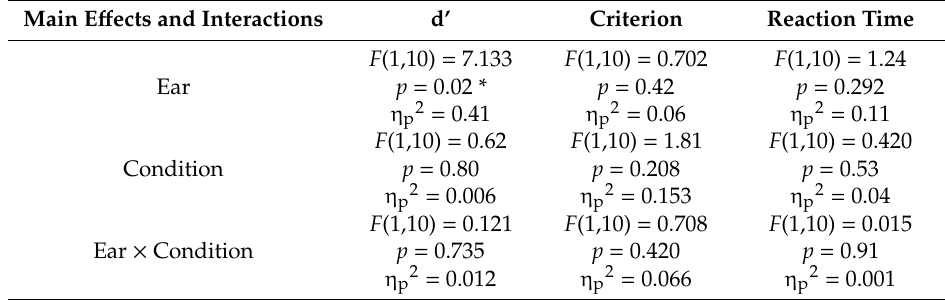
Table 8. Results of repeated-measures ANOVA for d’ (sensitivity), criterion and reaction times obtained in the active listening condition (P300 task). (* stands for p <